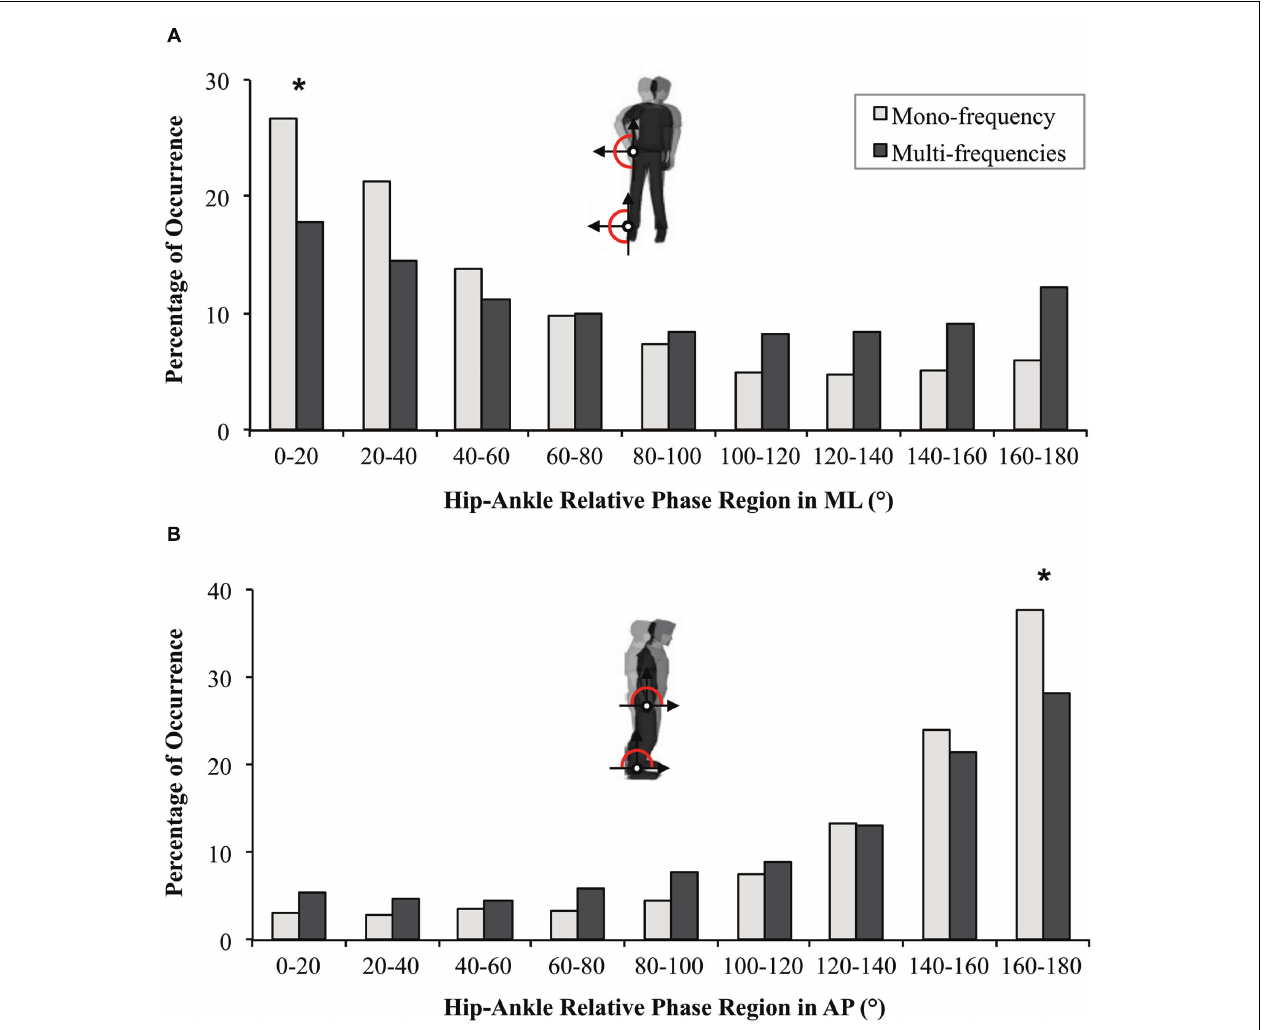
FIGURE 4 | Distribution of relative phase ( Ø h - a ) in ML (A) and AP directions (B) during Solo situations for participants from the Mono-frequency group (light gray) and from the Multi-frequency group (dark gray). Statistical differences between the two groups are indicated by ∗